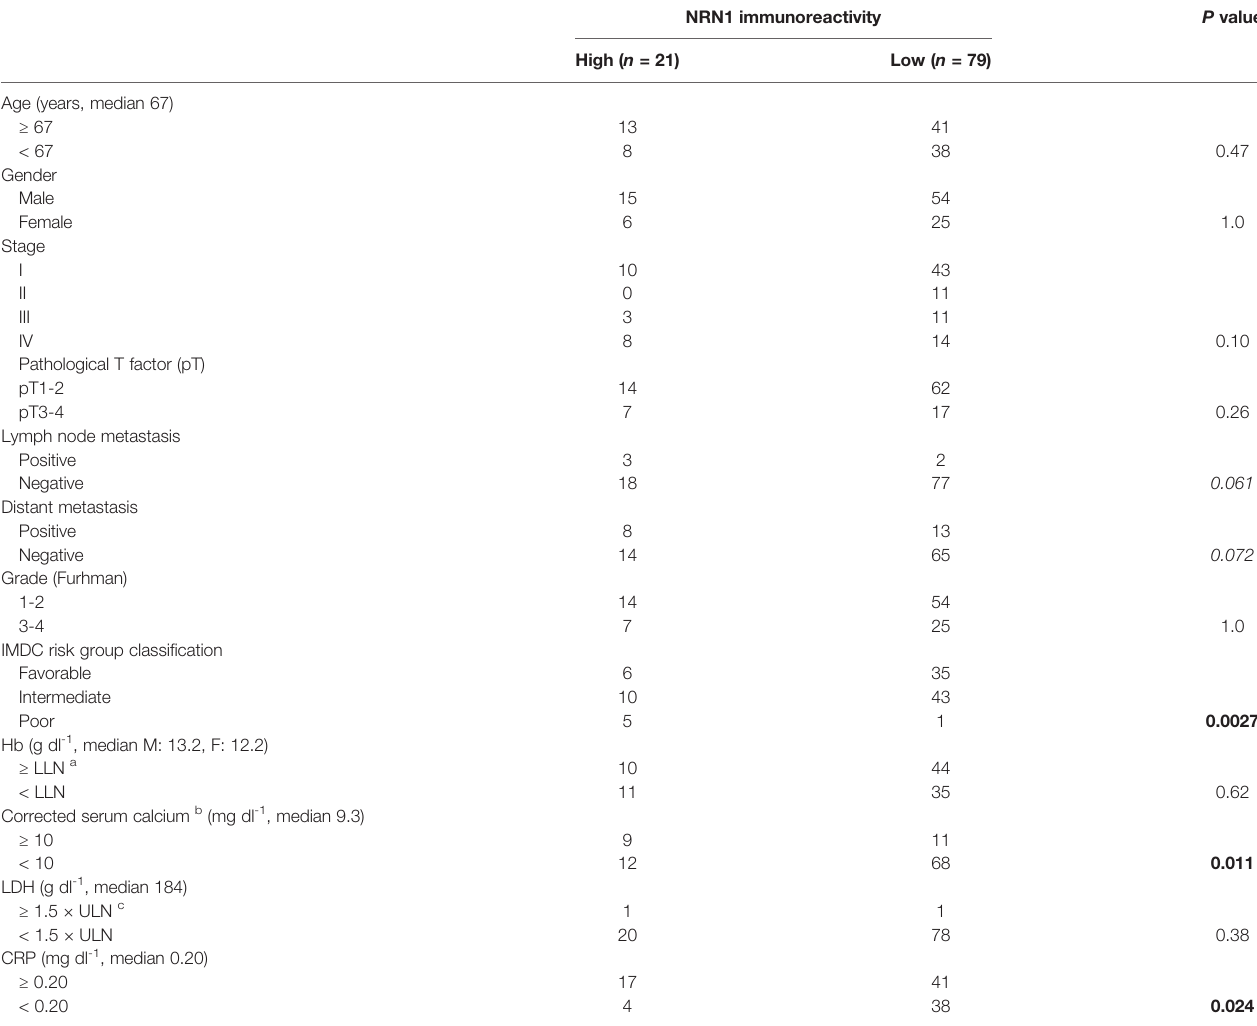
TABLE 1 | Association between NRN1 immunoreactivity and clinicopathological factors in 100 clear cell